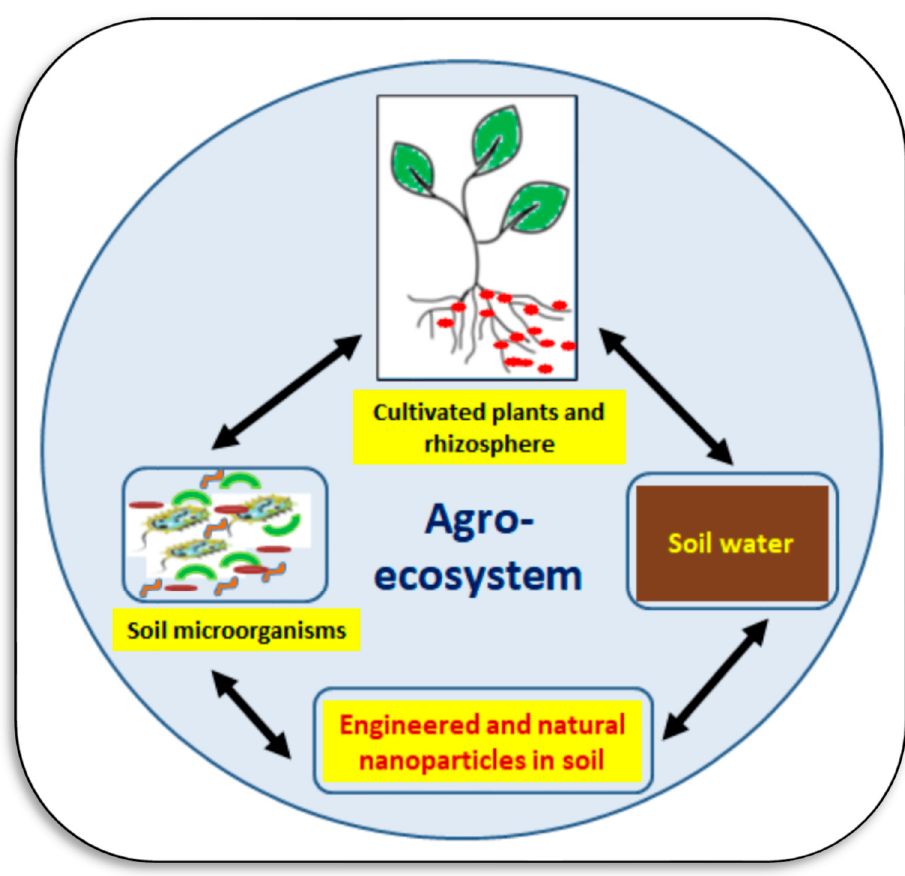
Figure 13. A simplified general overview of the interactions among soil microbes, cultivated plants, soil water (soil solution), and different kinds of nanoparticles (natural and atherogenic) in an agroe- cosystem. All these components interact together in soil, with many positive and negative impacts on soil fertility. Sources: